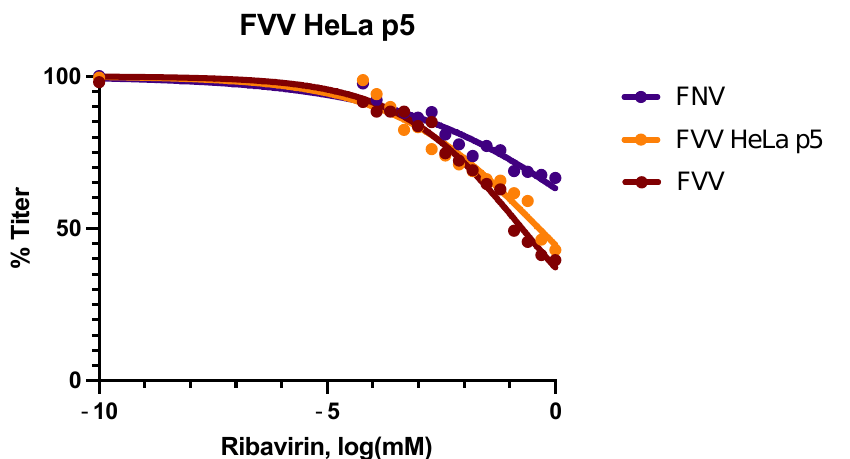
Figure 2. Ribavirin sensitivity curve for FVV HeLa p5 in Vero cells. FVV is in burgundy (0.20 µM, R 2 = 0.96), FVV HeLa p5 (0.45 µM, R 2 = 0.93) is in yellow, and FNV (17.31 µM, R 2 = 0.79) is in purple .